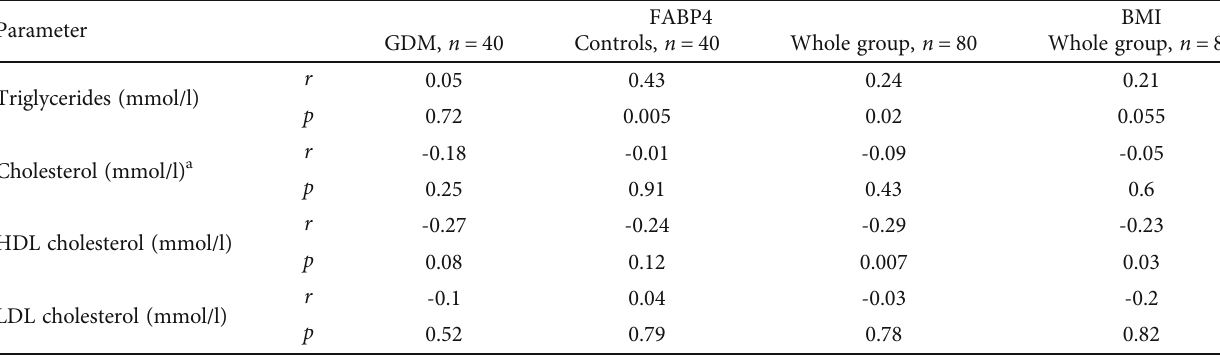
Table 3: Spearman correlations between FABP4 and lipid metabolism